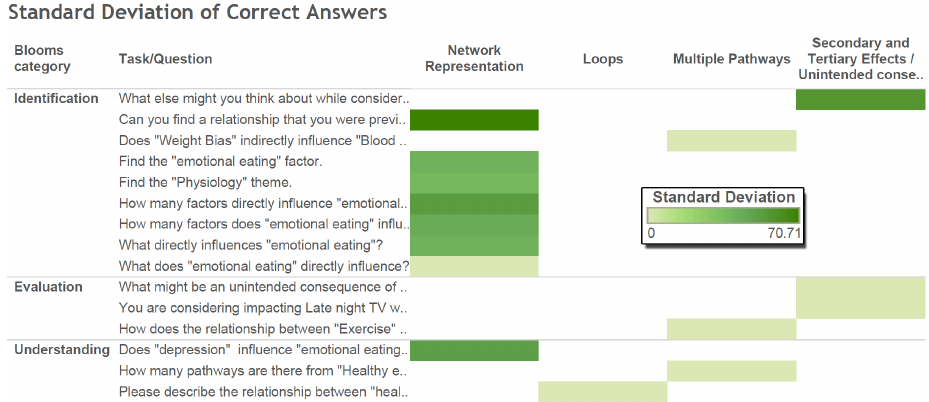
Figure 9. Average percentage of correct answers ( top ) and standard deviation ( bottom ) across